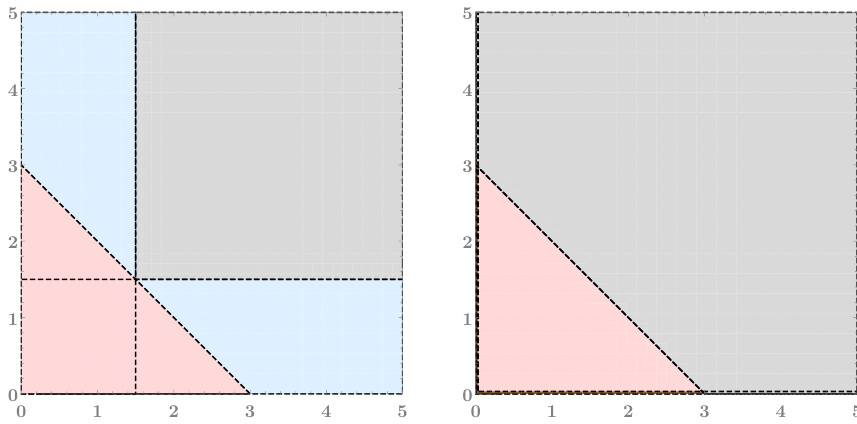
Figure 6 . The ( h 0 ; (cid:22) h 0 ) plane: the light red shaded region contributes to Z L and given by the states with h 0 +(cid:22) h 0 < c= 12. The complement of this contributes to Z H . The naive HKS cut makes the union of red and blue shaded region to be the \Light" region. But this brings in the problem of having in(cid:12)nite number of operators in the light region. This cut is applicable to the analysis sensitive to primaries as well with a shifted central charge c 7! c (cid:0) 1. The picture on the right emphasizes that one needs to treat the zero twist operators separately for some part of the